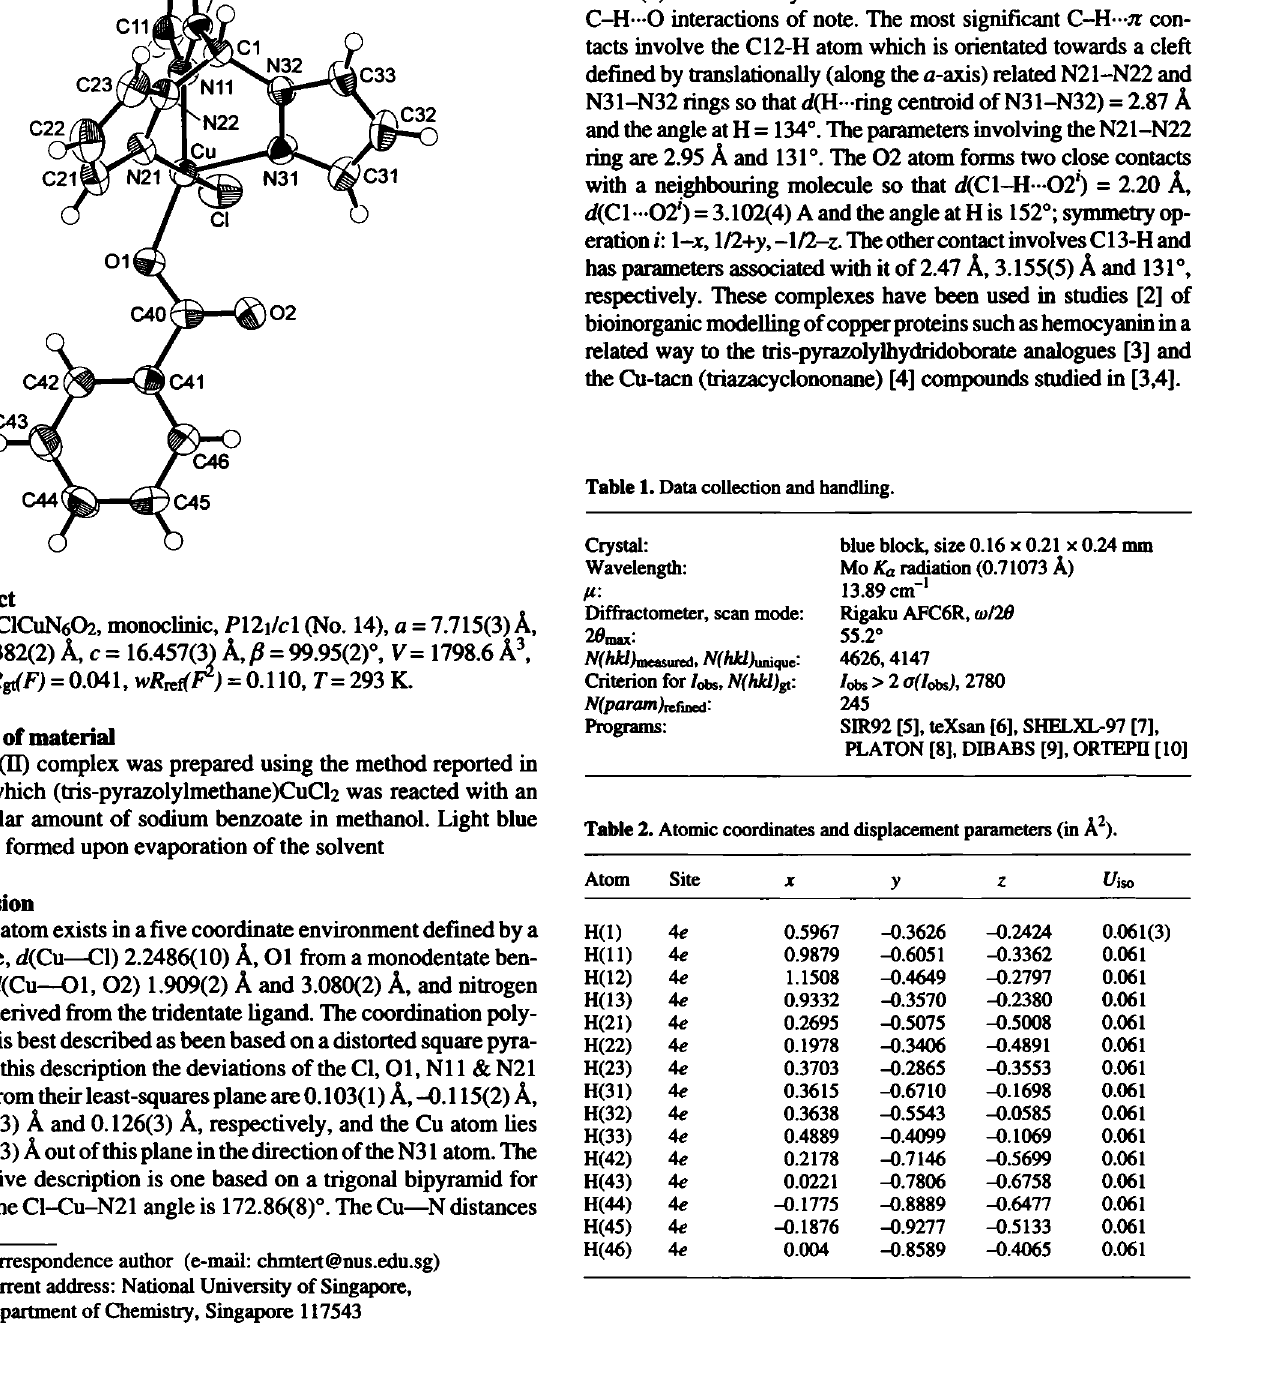
Table 2. Atomic coordinates and displacement parameters (in Â 2